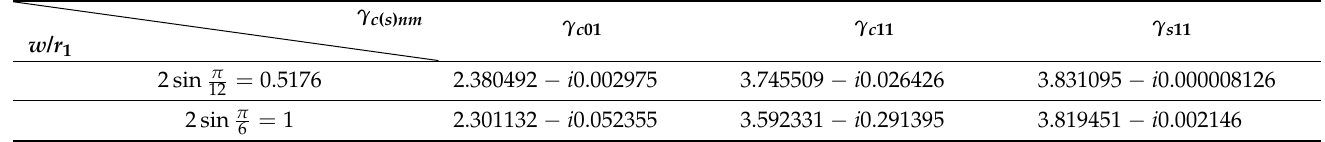
Table 1. Selected complex eigenvalues of the open circular